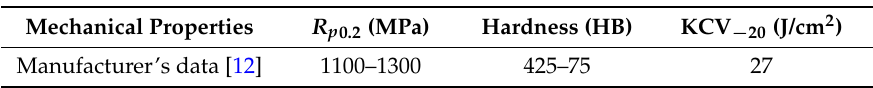
Table 1. Selected mechanical properties of the investigated steel in the as-received condition. KCV: notched impact strength.